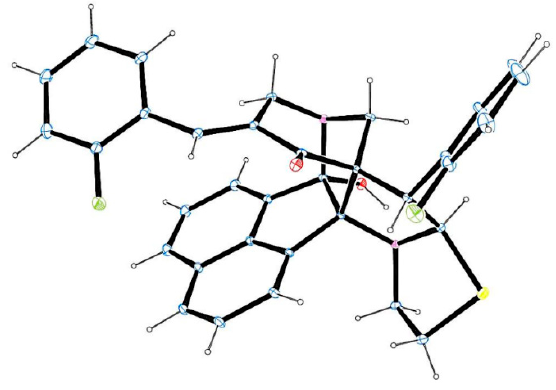
Figure 2. ORTEP diagram of 6f .